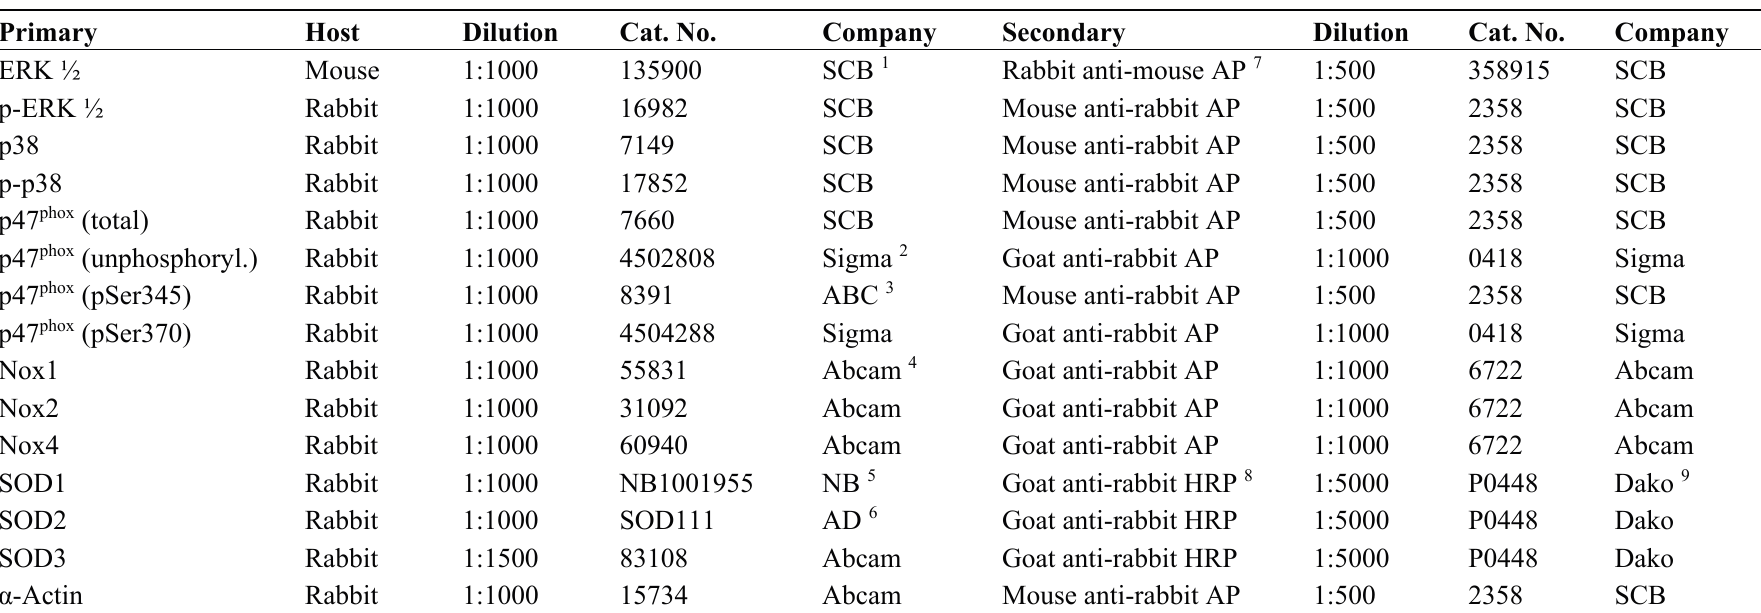
Table 1. Primary and secondary antibodies used in Western blot